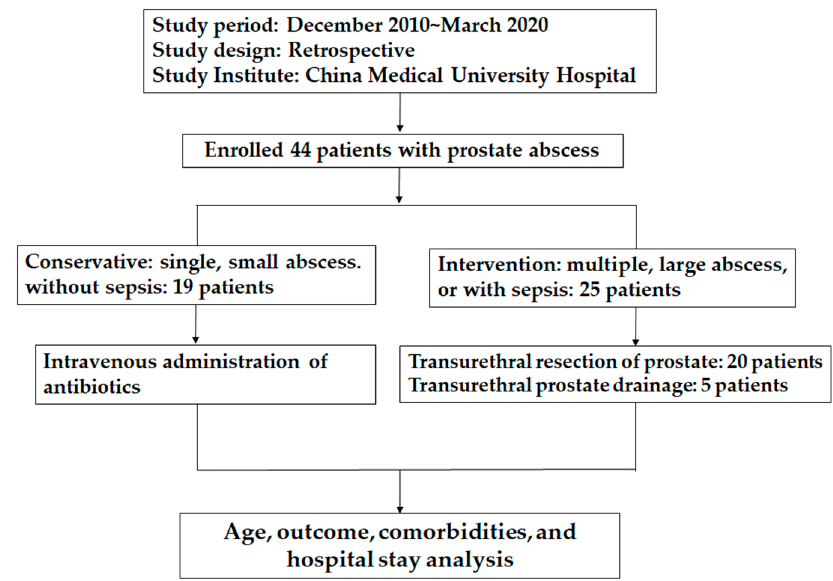
Figure 1. Flow chart of retrospective analysis of the patients with a prostate abscess.